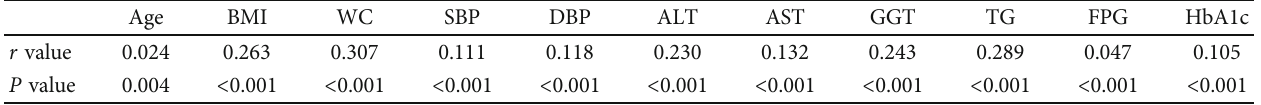
Table 3: Correlations between MHR and metabolic parameters.